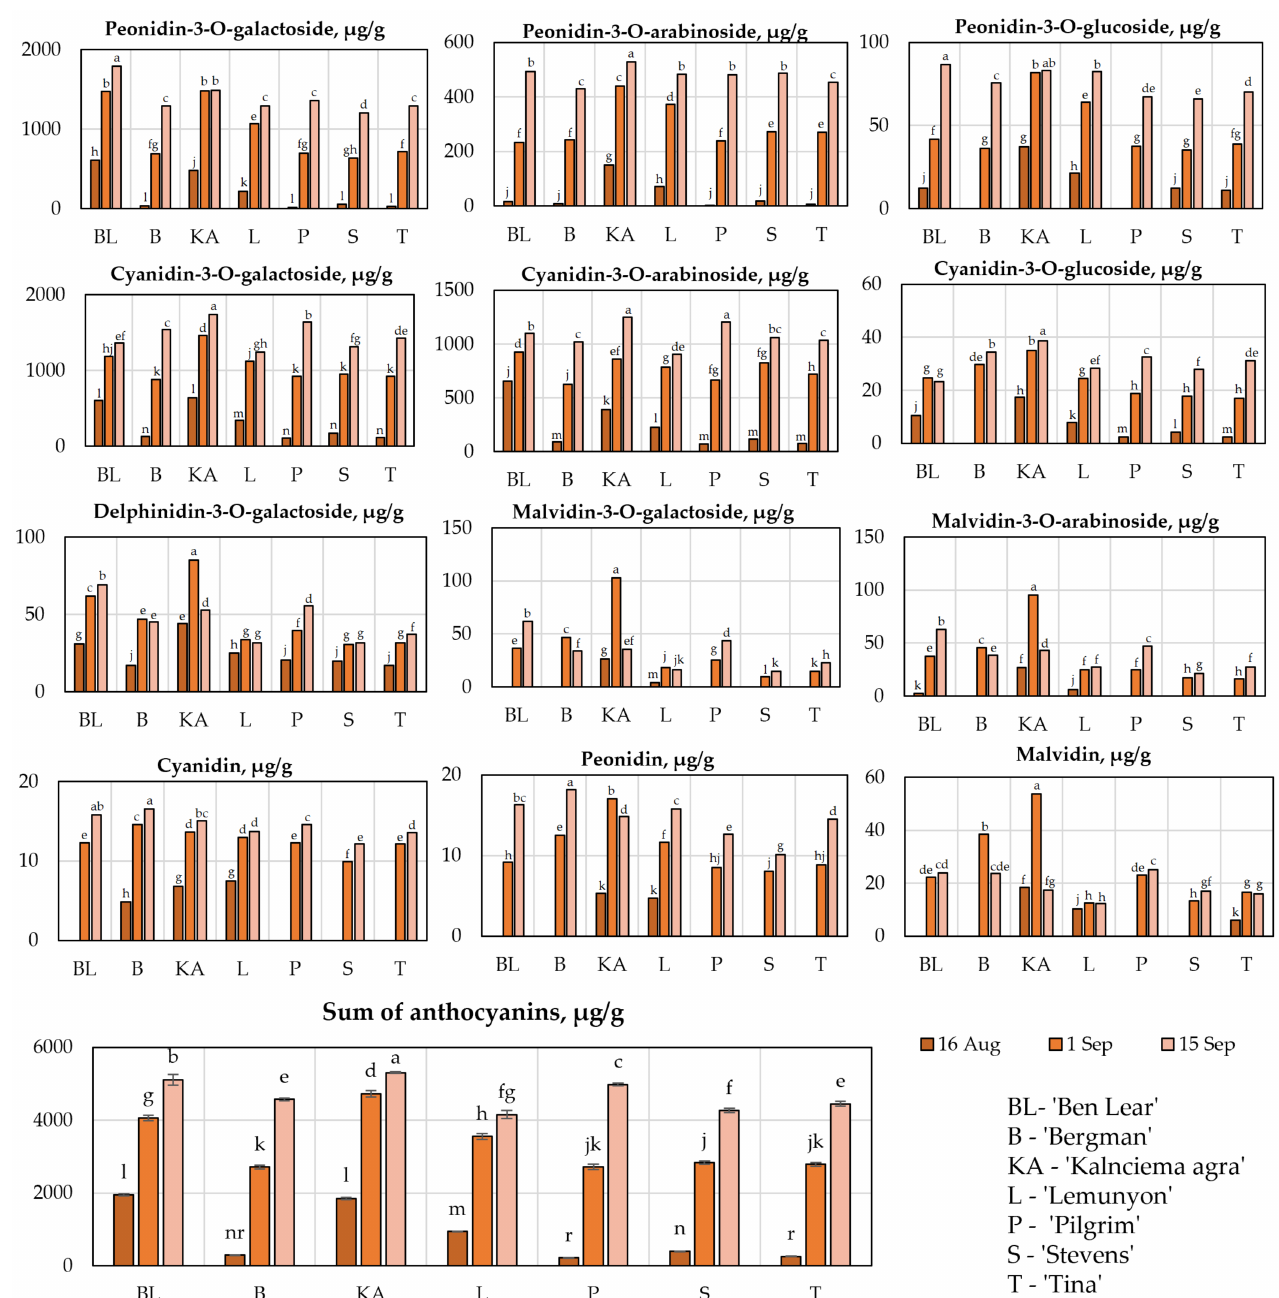
Figure 1. Variability in the qualitative and quantitative compositions of the anthocyanins and antho- cyanidins in the fruit samples of the large cranberry cultivars. Different letters indicate statistically significant differences between the detected total anthocyanin contents in the cranberry fruit samples ( p <